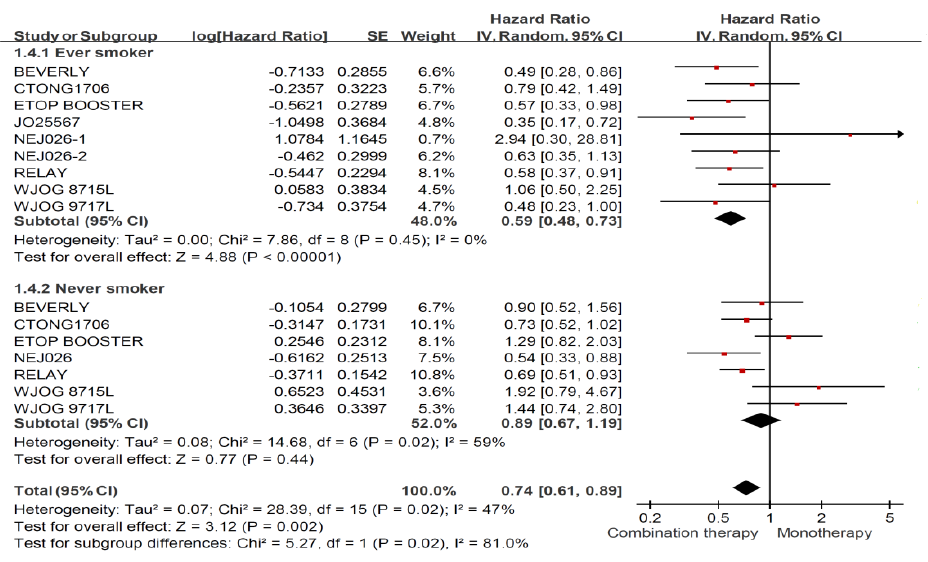
Figure 3. Forest plot and pooled hazard ratio for progression free survival (PFS) among all enrolled patients (combination therapy vs. monotherapy).l